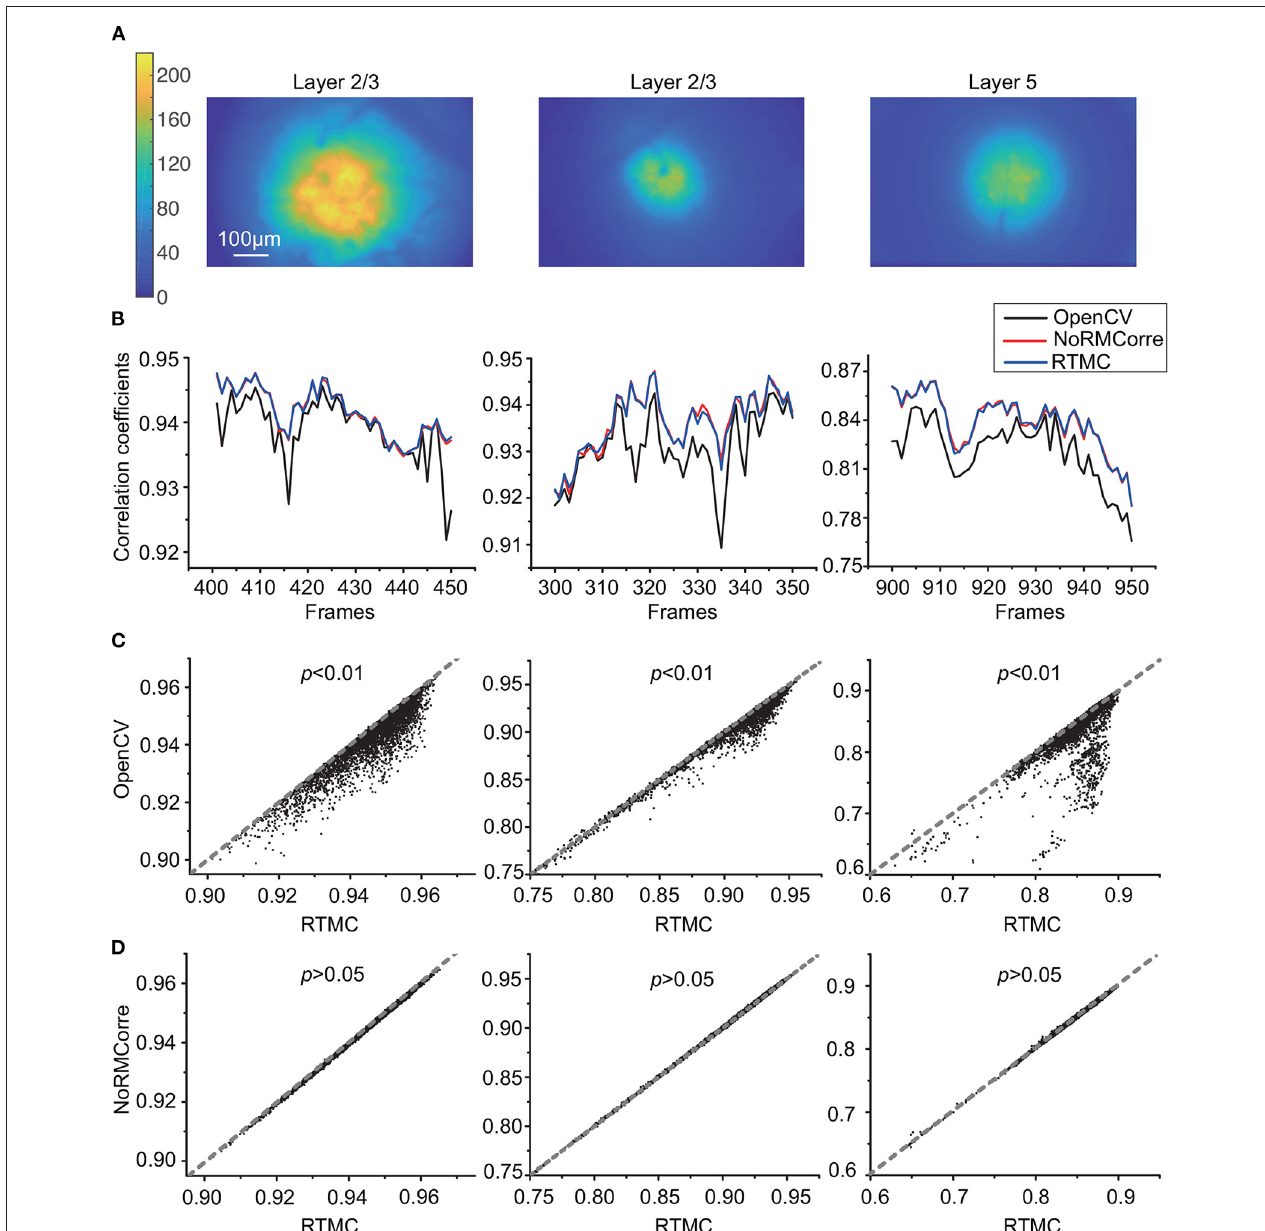
FIGURE 4 | Accuracy comparison of OpenCV template matching, rigid NoRMCorre and RTMC applied to three in vivo mouse motor cortex datasets from layer 2/3 and layer 5, with 5,000 frames in each dataset. (A) : Temporal mean projection images of three datasets (B) : Correlation with mean (CM) metric for a subset frames in each dataset. (C,D) : Scatter plots of frame-by-frame CM from 3 datasets of RTMC vs. OpenCV (C) and RTMC vs. NoRMCorre (D) . RTMC has no significant difference with NoRMCorre and they both improve over OpenCV template matching (RTMC vs. OpenCV, p <0.01; RTMC vs. NoRMCorre, p >0.05, Wilcoxon test).